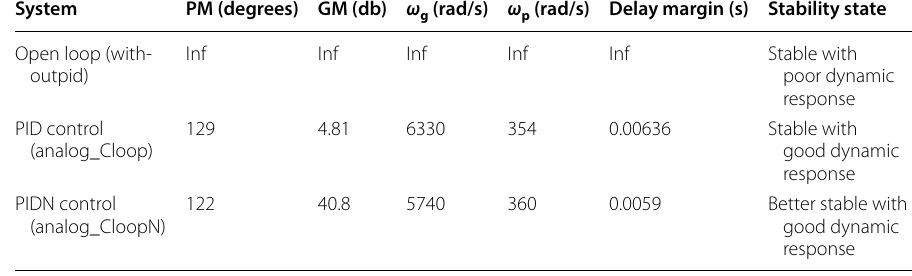
Table 6 Comparison of stability analysis in analog domain of BBC in buck mode of operation System